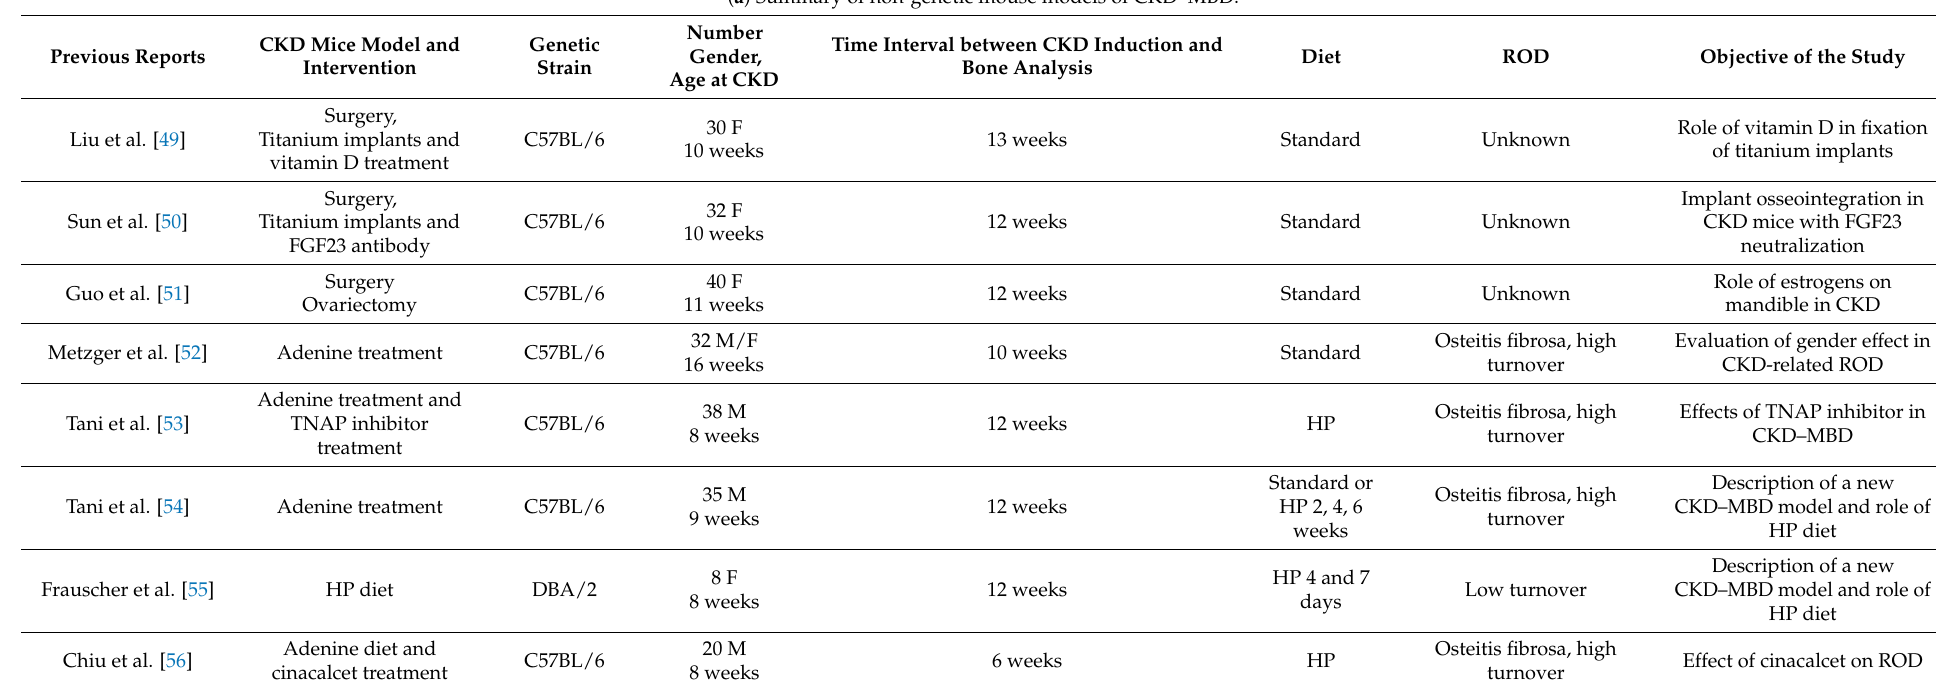
( a ) Summary of non-genetic mouse models of